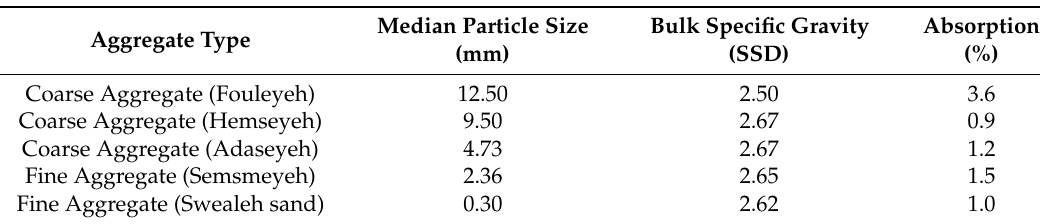
Table 1. The physical properties of the used aggregate.